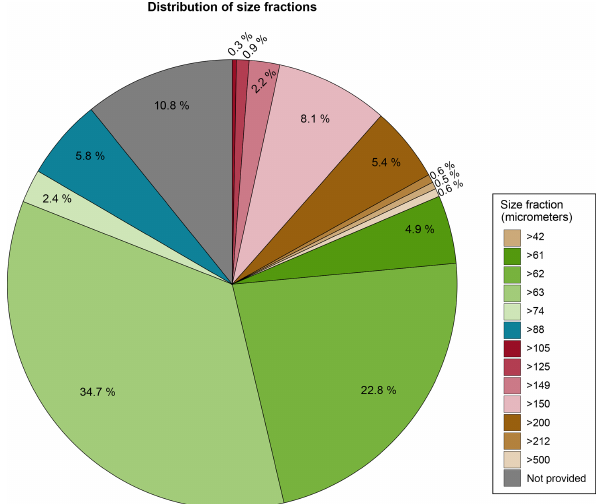
Figure 4. Distribution of the size fractions used in the benthic foraminiferal studies included in BENFEP_v1. The graph was elab- orated with the “ggforce” (Pedersen, 2022) and “tidyverse” (Wick- ham et al., 2019) packages using R version 4.2.1 (R Core Team,